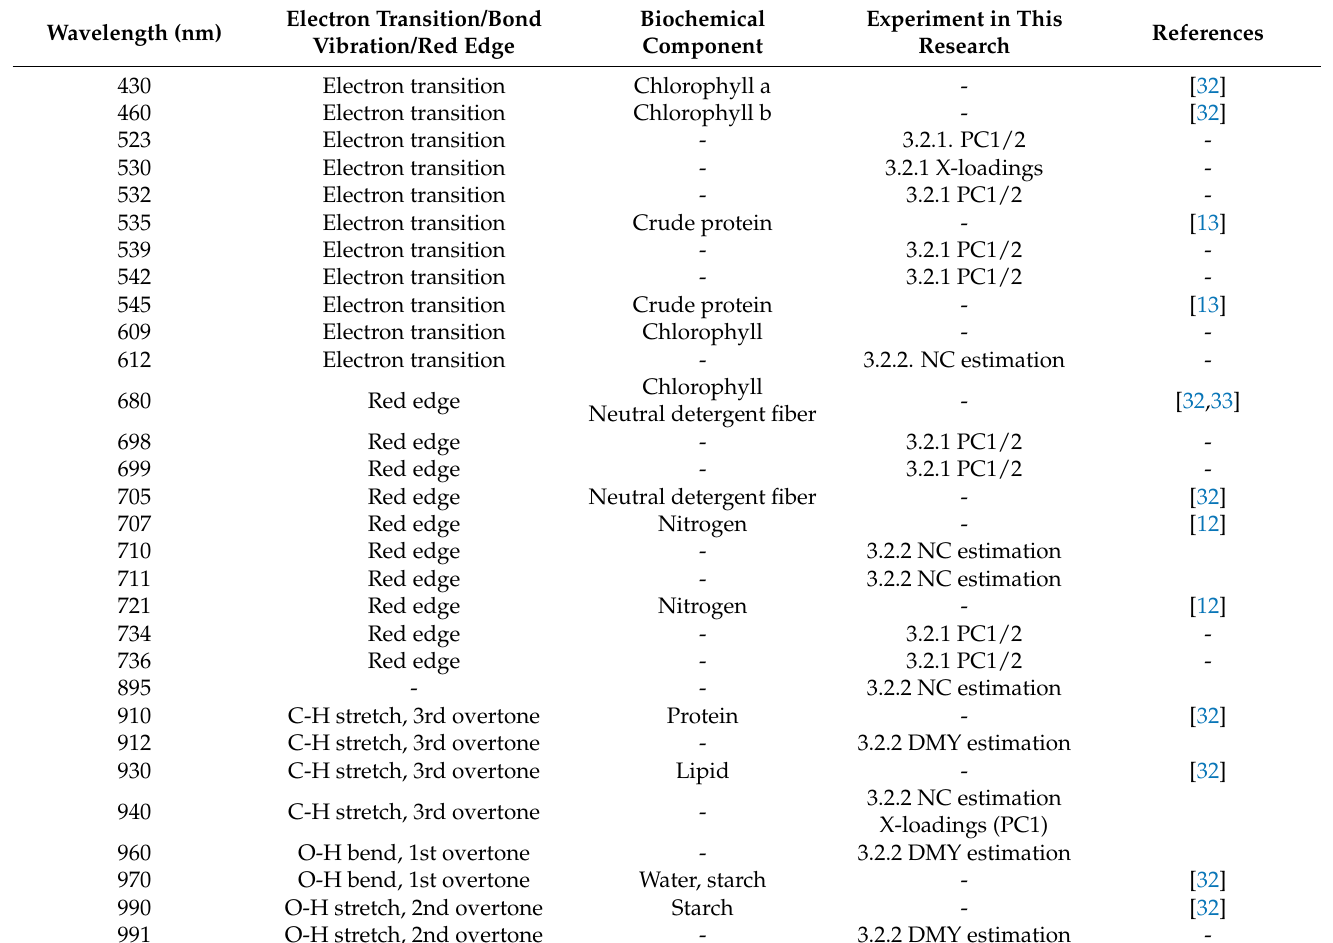
Table A1. Contributed wavelength to estimation model, well-known wavelength and their chemi- cal/biochemical